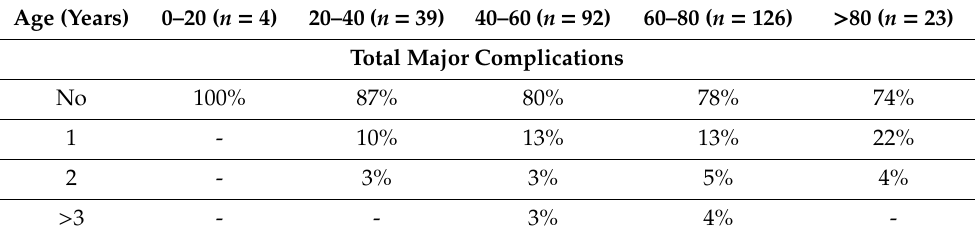
Table 7. Major complication rates in relation to the patient’s